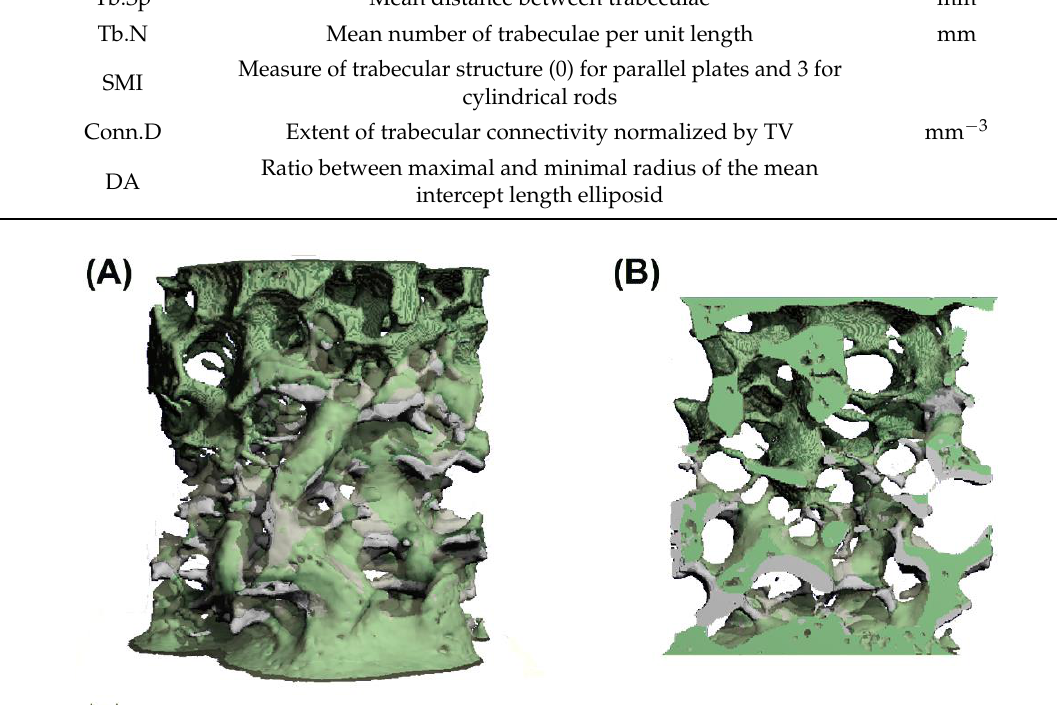
Figure 2. Overlay of two 3D Images, acquired from step-wise testing of an SB 526 specimen at 50 N (magenta) and 300 N (gray); ( A ) front view, ( B ) inside view.